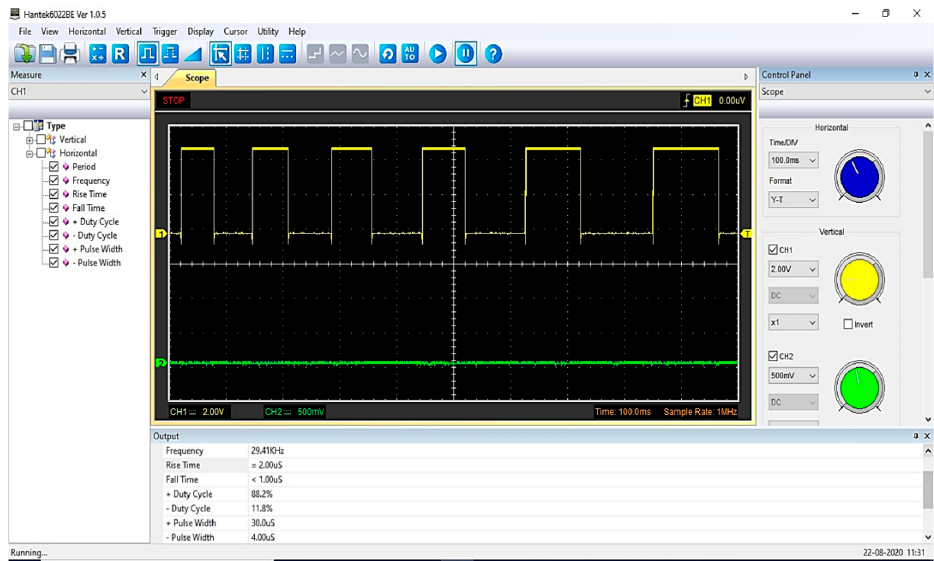
Figure 8. Image of waveform frequency on the user interface of the USB digital oscilloscope.